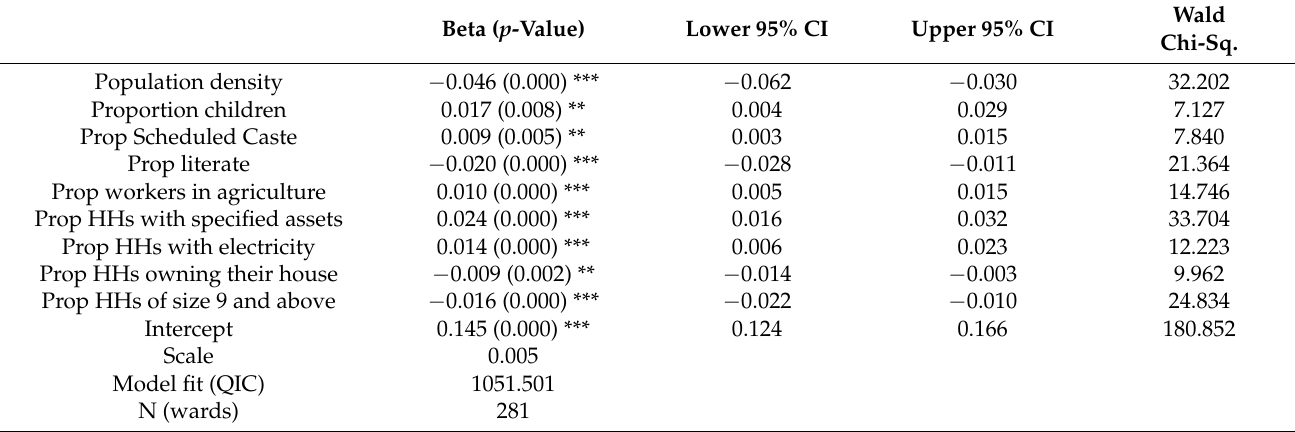
Table 5. Generalized estimating equation for predicting September NDVI using ward level socio-demographic